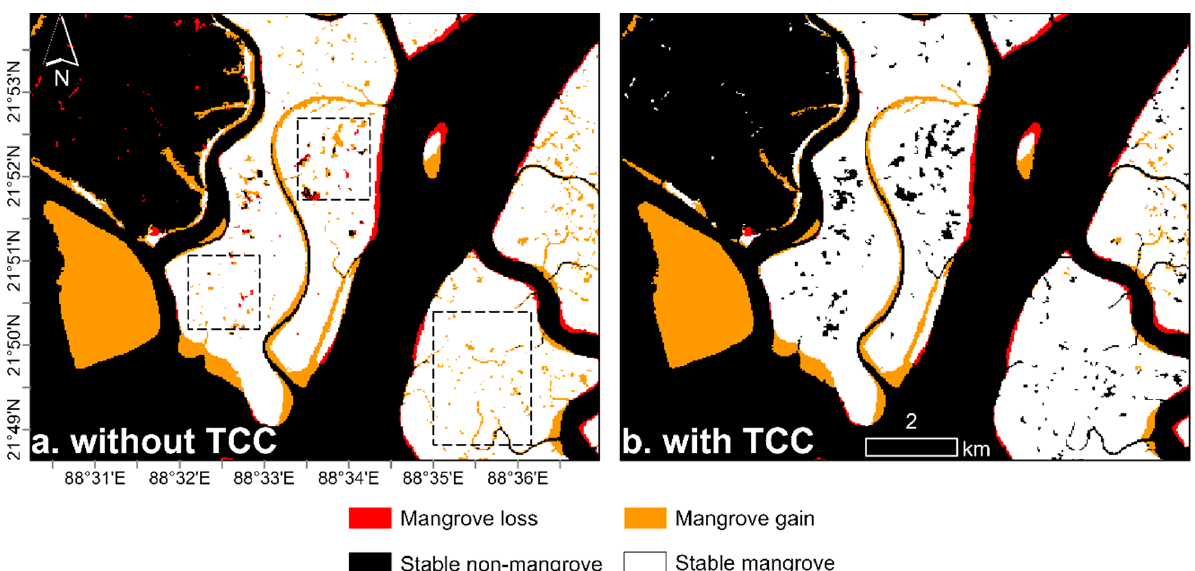
Figure 10. Comparison of change detection results of ( a ) using classification differencing and ( b ) our temporal consistency checking approach. Dashed boxes mark some obvious classification errors.